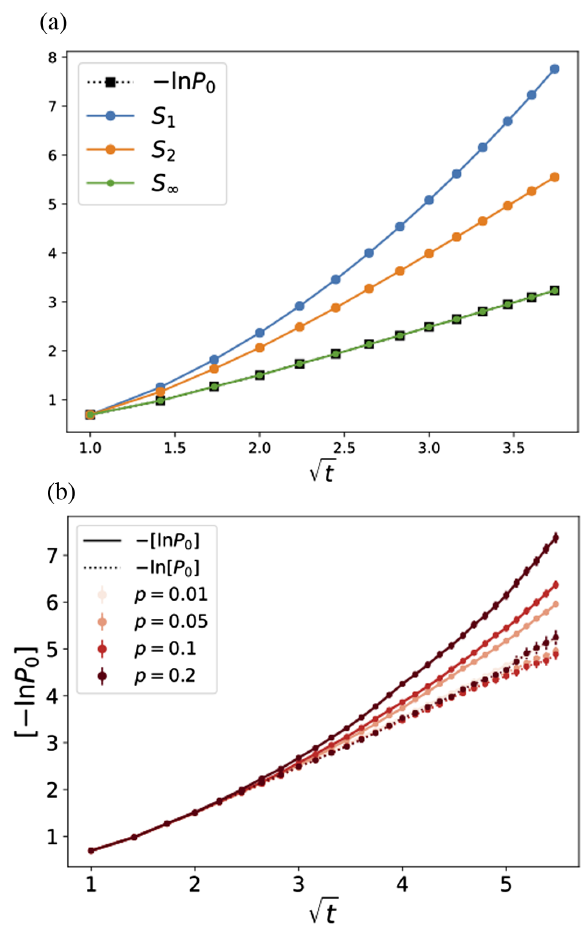
FIG. 12. Entanglement dynamics in the statistical mechanics model. (a) Plot of S 1 , S 2 , S ∞ , and − ln P 0 versus